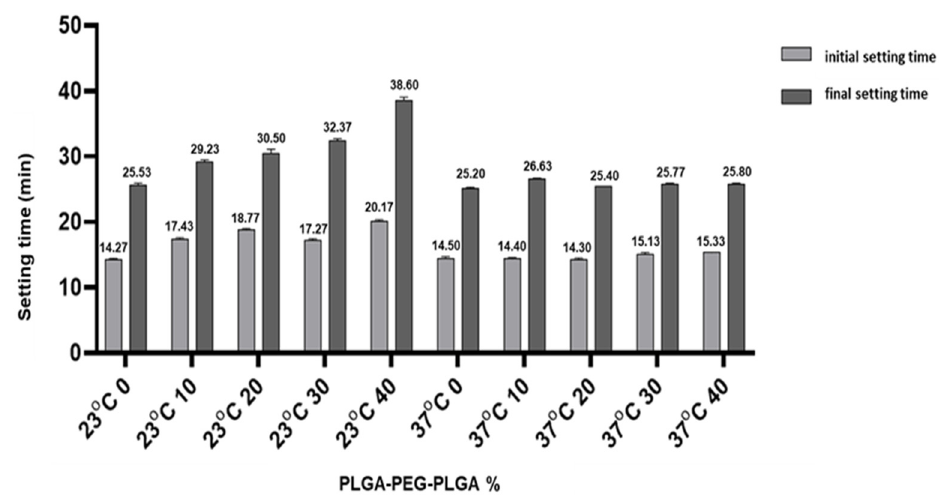
Figure 4. Curing time of composite bone cement with different PLGA-PEG-PLGA temperature-sensitive hydrogel contents at different temperatures.